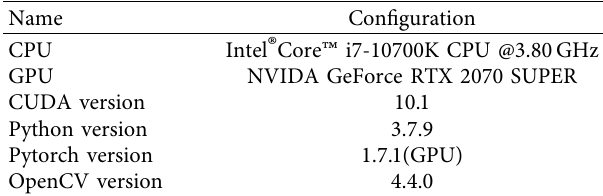
Table 1: Environment configuration